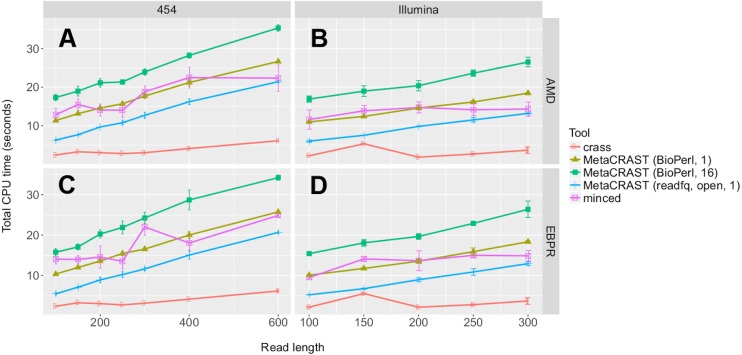
Evaluation of MetaCRAST, Crass, and MinCED run times on simulated AMD (A and B) and EBPR (C and D) metagenomes.We evaluated seven different combinations of algorithms, implementations, and parameters. We evaluated both Crass and MinCED with default parameters. For MetaCRAST, we evaluated five different conditions differing in parallelization and metagenome loading method—BioPerl loading and 16 threads, BioPerl and a single thread, readfq with mce_open for loading and 16 threads, readfq with mce_open and a single thread, and readfq with the standard open routine and a single thread. The procedure for generating the simulated metagenomes is described in Materials and Methods. Run time was calculated as the sum of the user and system time (together the total CPU time). All data points represent the averages of three individual simulations and are presented with error bars representing two times the standard error above and two below the average.